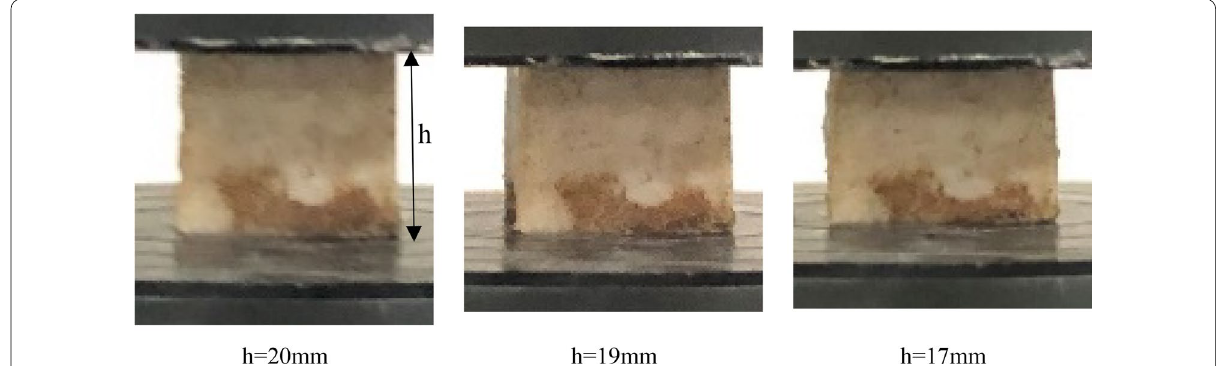
Fig. 14 Morphology of the PCL‑sand cubic sample in the uniaxial compression test.